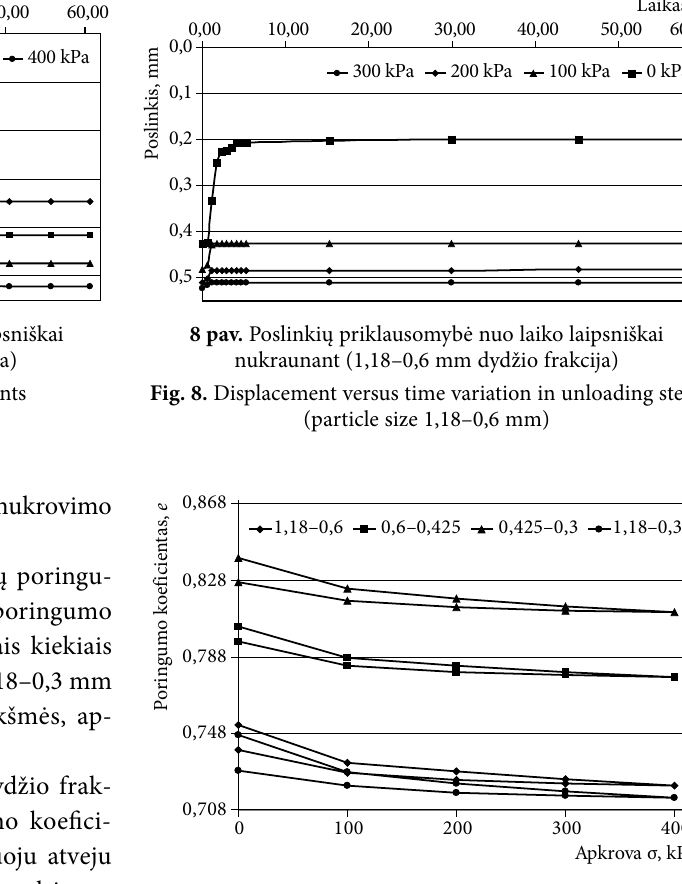
Fig. 9. Void ratio versus